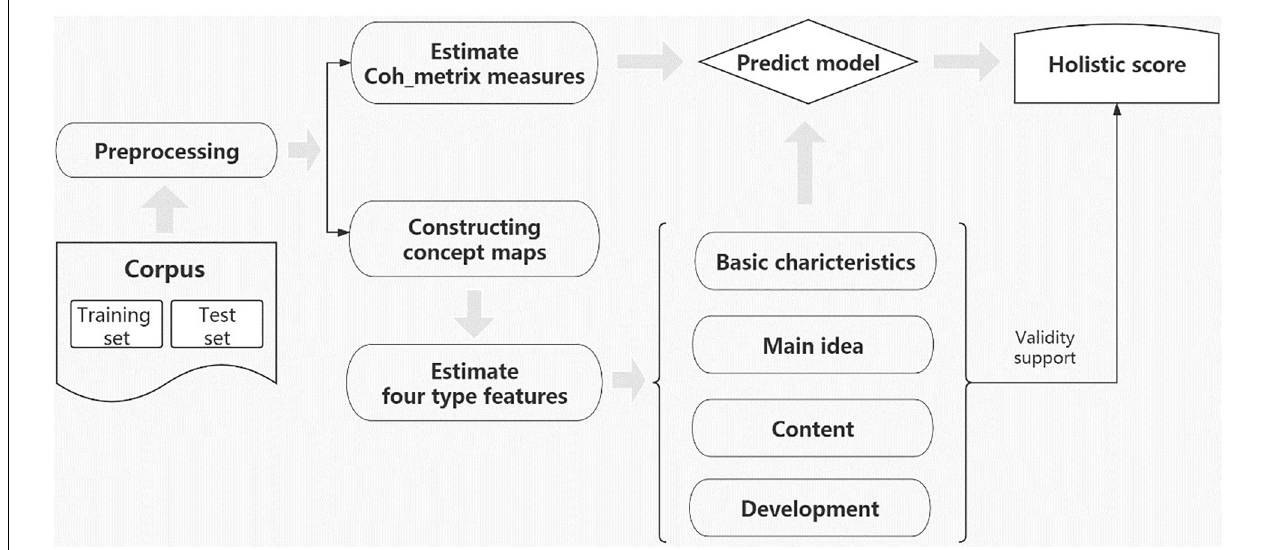
FIGURE 1 | AECE architecture.